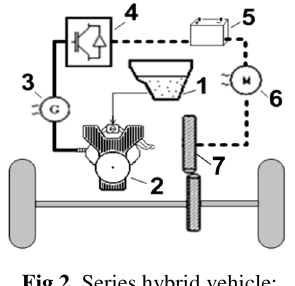
Fig 2. Series hybrid